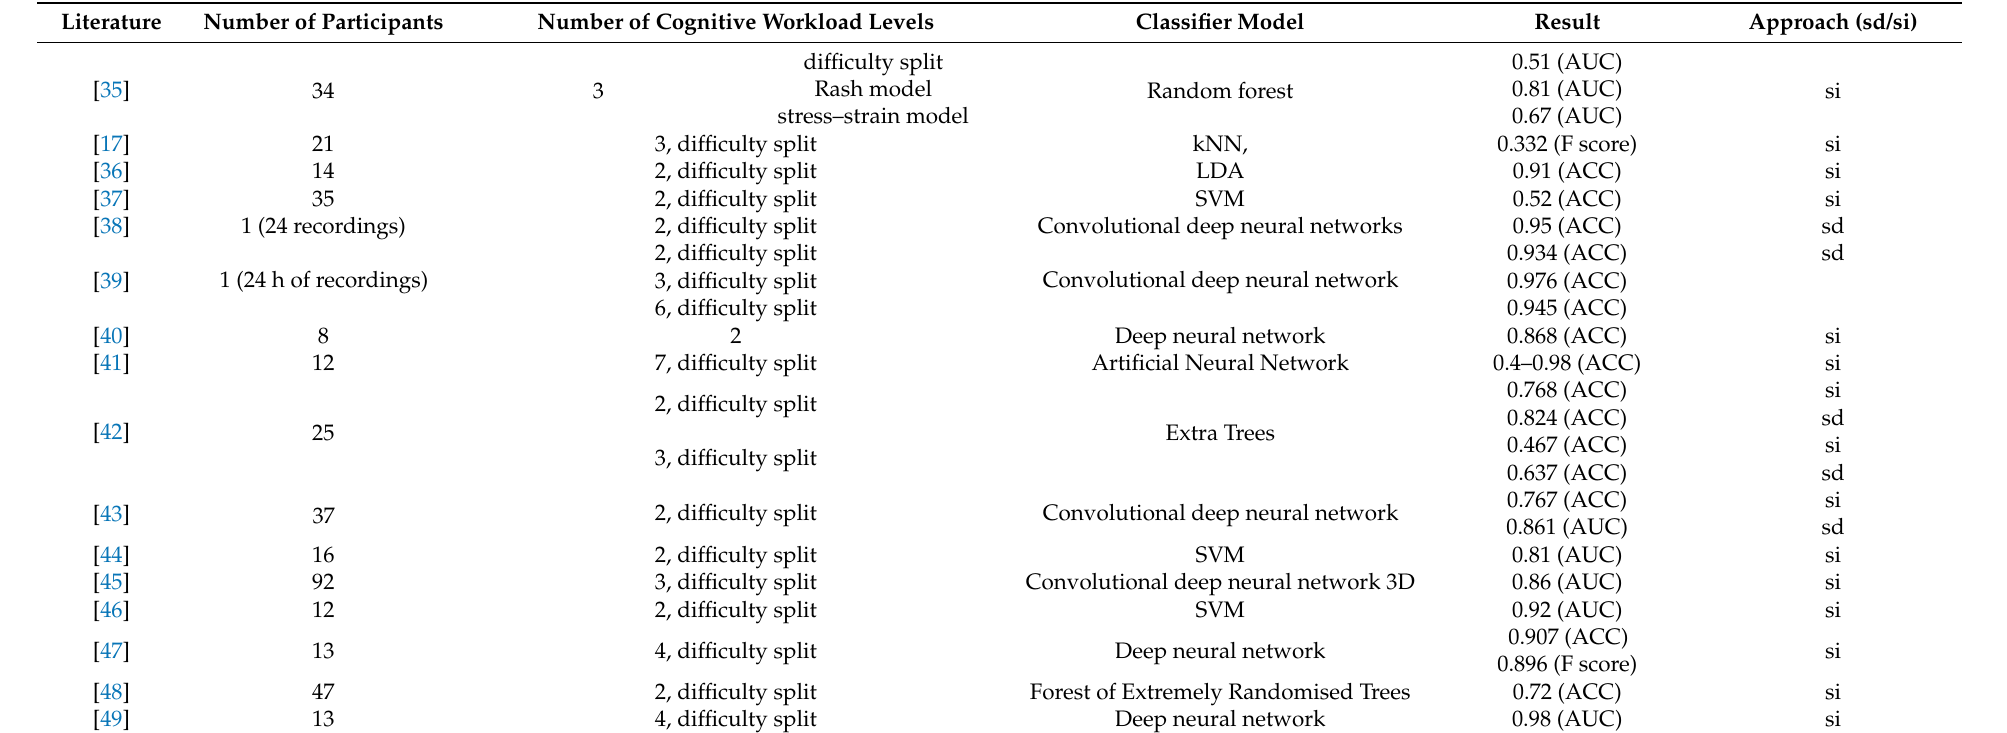
Table 1. A review of the